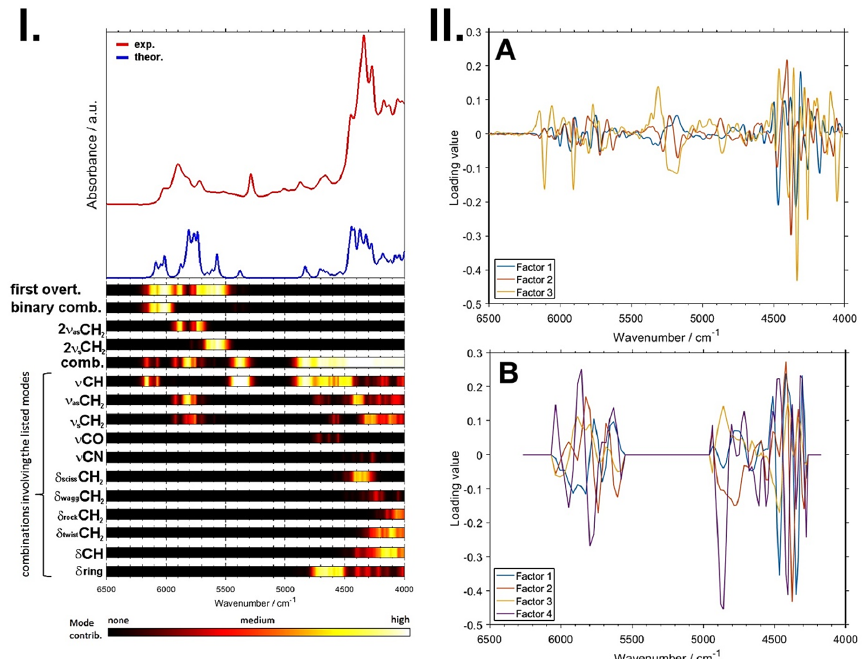
Figure 9. Panel ( I ): simulated spectrum elucidates vibrational contributions to NIR spectrum of piperine. Panel ( II ): this information enables the interpretation of the chemical information in the loading plots for the PLSR model of piperine content in black pepper developed for the NIR spectral sets measured with ( A ) a benchtop Büchi NIRFlex N-500; and ( B ) a miniaturized microPHAZIR spectrometer. Reproduced (CC-BY 4.0 license) from [97].